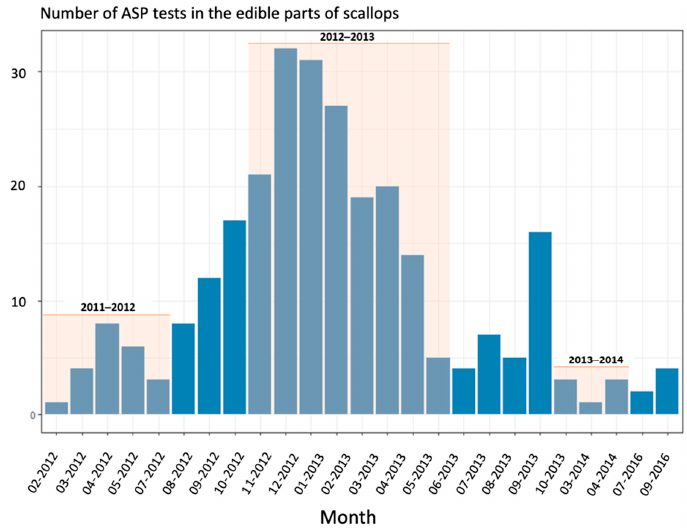
Figure 7. Evolution of the number of ASP tests per month on edible parts of scallops in the eastern Channel. Pink areas correspond to the scallop fishing seasons. The absolute error calculated between the theoretical closure values and the observed closures showed that of the total data, 49.58% had results of theoretical closure estimates consistent with the recorded and observed closures. For the rest of the data, 42.86% show discrepancies that were explained by management strategies adapting to the evolution of